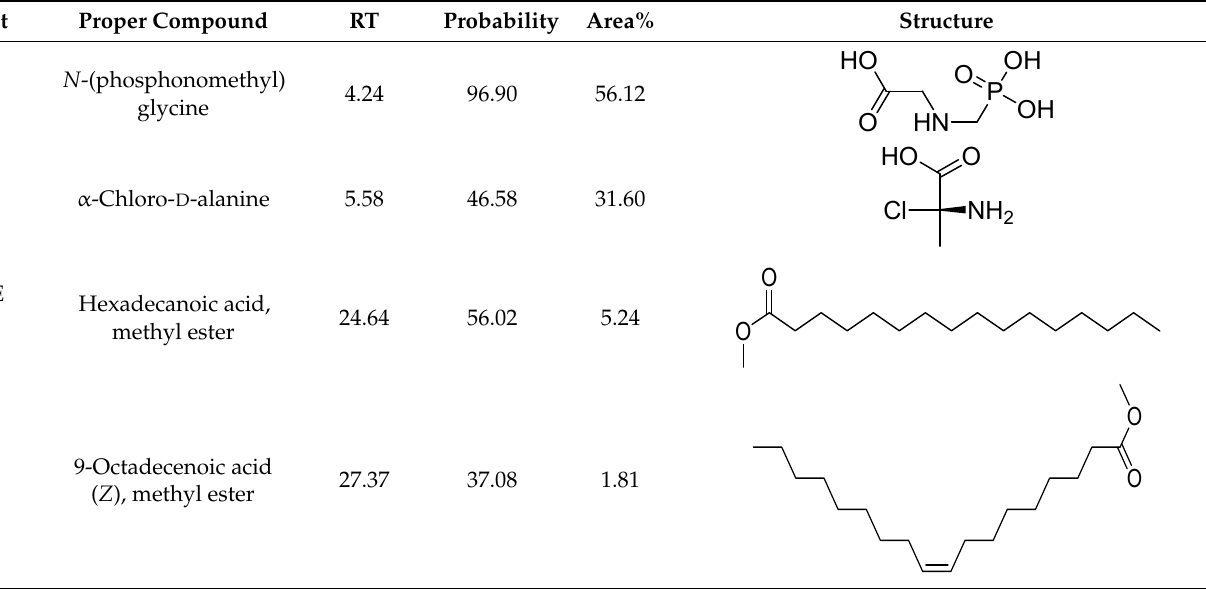
FZDE: fresh fruit of “Zaghloul” date extract, FHDE: fresh fruit of “Hayany” date extract, FADE: fresh fruit of “Amhaat” date extract.